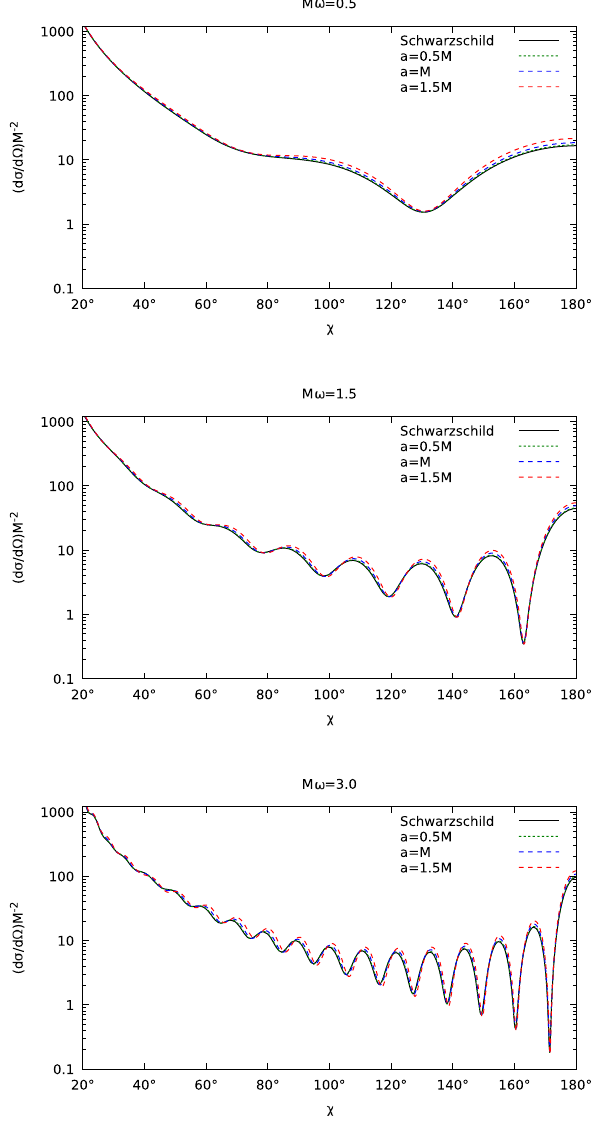
Fig. 3 The scalar differential scattering cross section of regular black holes described by the Simpson–Visser metric with different choices of M ω and a / M . We also show the Schwarzschild case for comparison